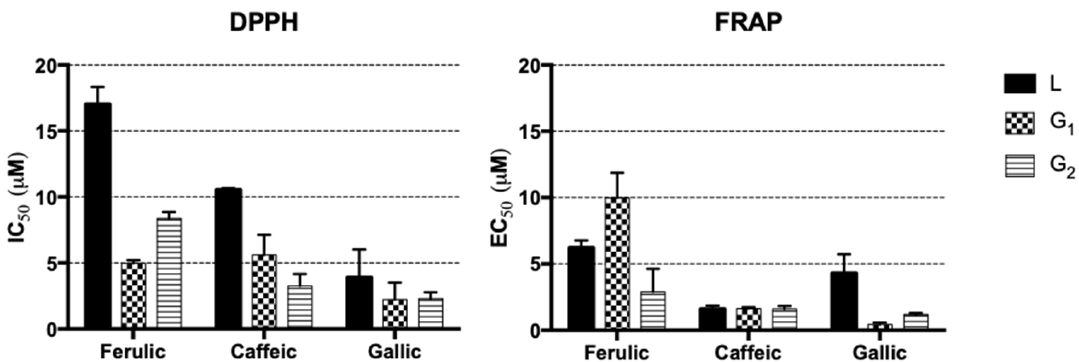
Figure 4. Antioxidant activity of polyphenolic dendrimers ( 1 - 6 ). Mean values ± SEM (standard error of the mean), representative of at least three independent experiments, are shown.